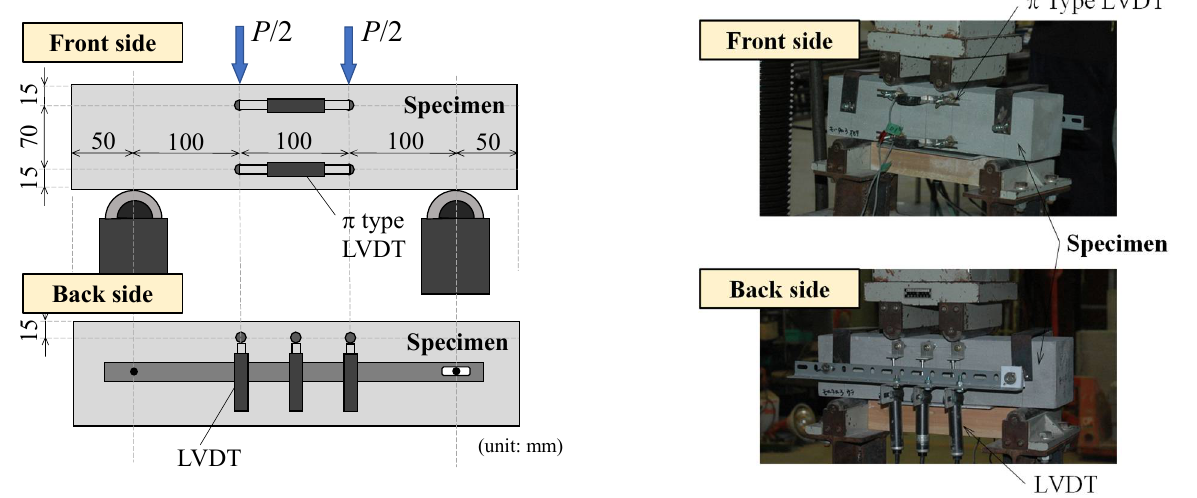
Figure 3. Four-point bending test setup and positions of linear variable displacement transducers (LVDTs). (unit: mm)